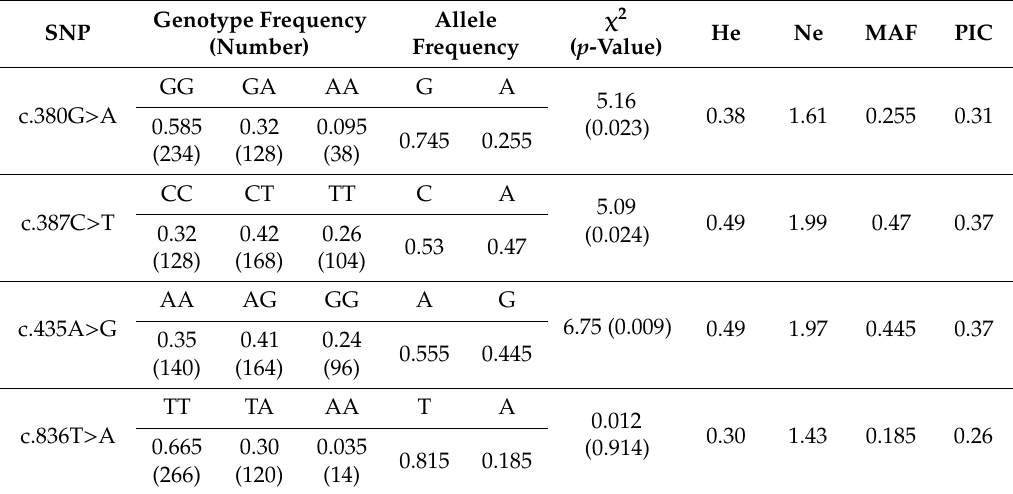
Table 2. Genotypic and allelic frequencies, value of χ 2 test, and diversity parameter of c.380G >